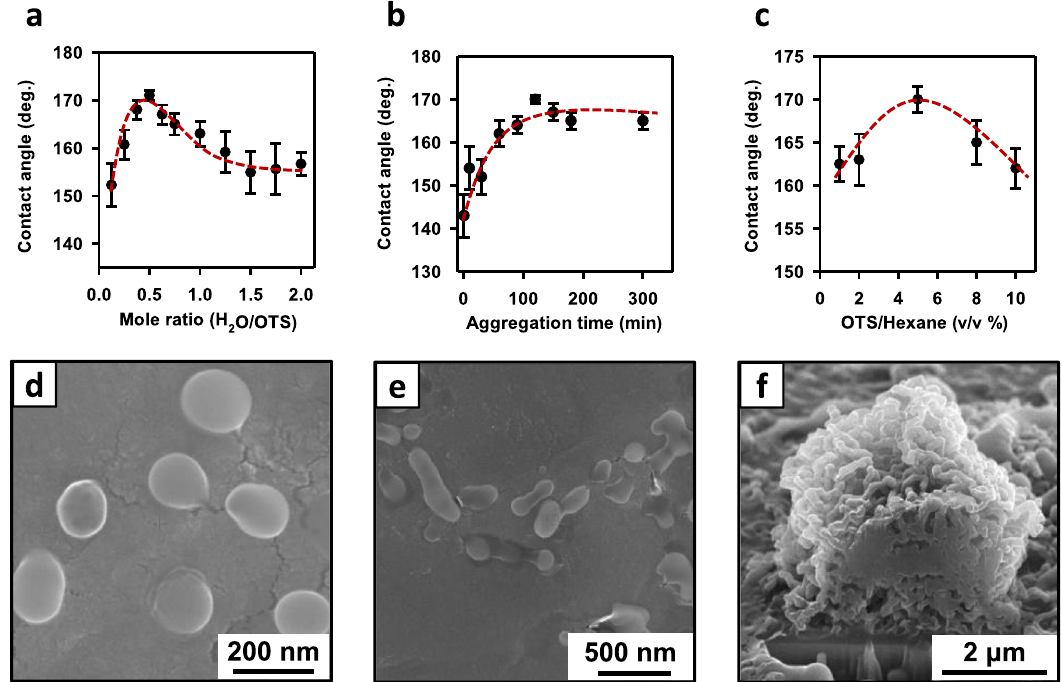
Fig. 3 Optimized fabrication and mechanistic investigation. a – c show the obtained water contact angle on modi fi ed glass slides as a function of the mole ratio (H 2 O/OTS), aggregation time, and dilution factor of the aggregated OTS in hexane, respectively. The errors represent the standard deviations from at least three independent experiments. d and e are SEM images of the hierarchical aggregates at different reaction stages. f shows the cross-section of a particle “ anchored ” on the substrate surface (cut with